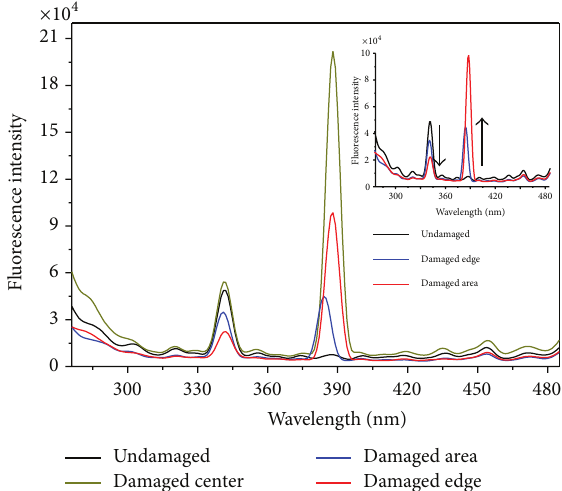
for different areas (undamaged, damaged edge, damage area, and = 256 damage core); 𝜆 ex